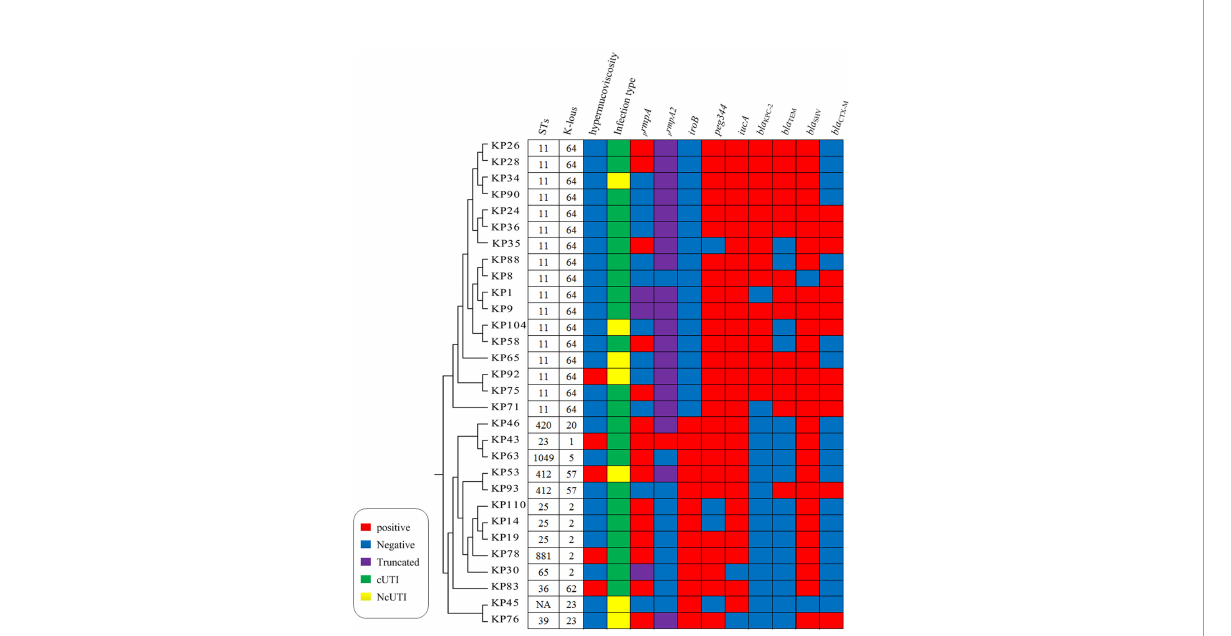
FIGURE 2 Molecular characterization of 30 hvKP isolates. NA, not determined. Homology analysis of 30 hvKP isolates was performed using BacWGSTdb software, and all K64 ST11 CR-hvKP strains belonged to the same